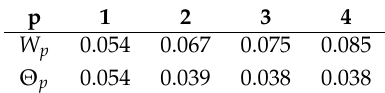
Table 1. Wasserstein and L p distance, ε = 0.1, λ = 0.5.